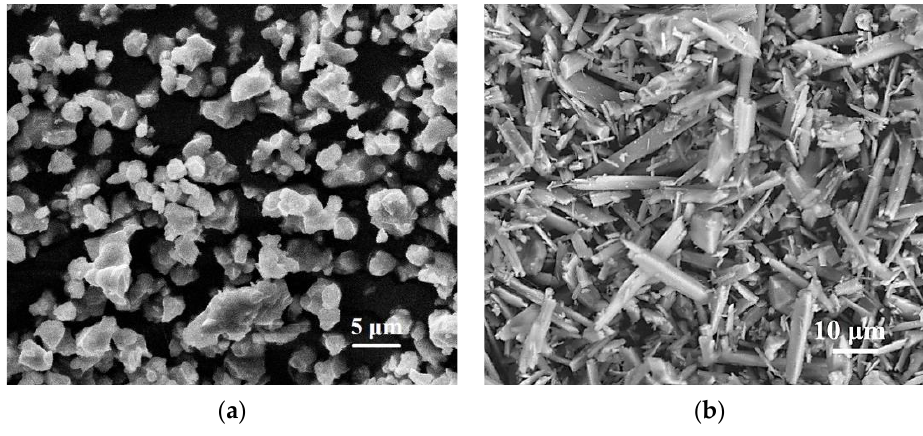
Figure 1. SEM images of β -TCP ( a ) and wollastonite ( b ) particles. The morphology and microstructure of the coatings were examined by the method of scanning electron microscopy (SEM, LEO EVO 50, Zeiss, Jena, Germany), as well